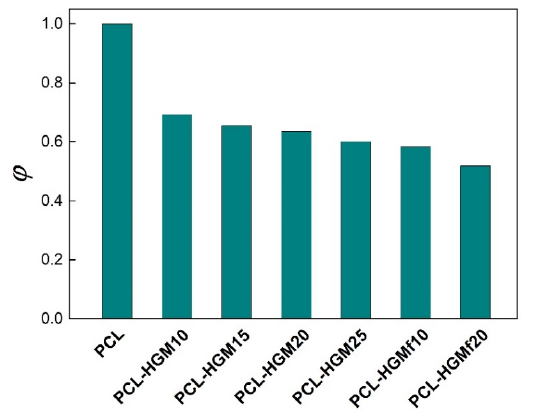
Figure 8. Nucleation activity factor for PCL and composites.